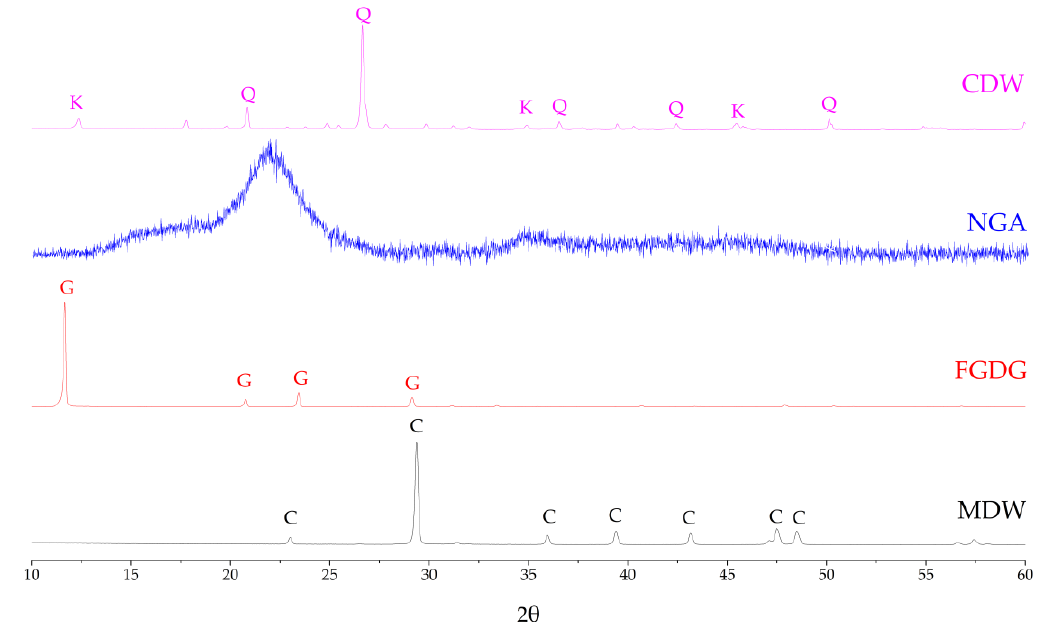
Figure 1. X-ray diffraction patterns of the four waste materials. C = calcite, G = gypsum, Q = quartz, and K = kaolinite.